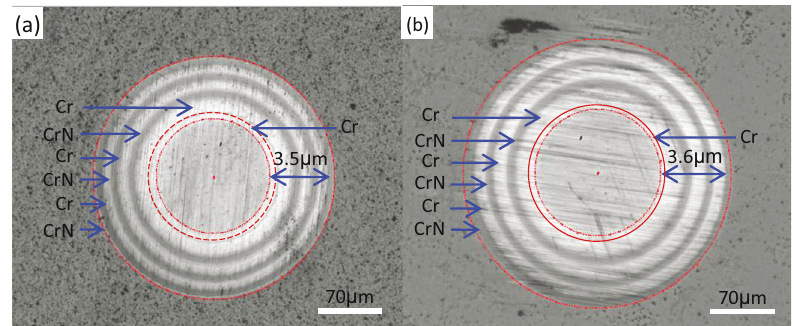
Figure 1: Crater grinding in ( a ) coating A and ( b ) coating